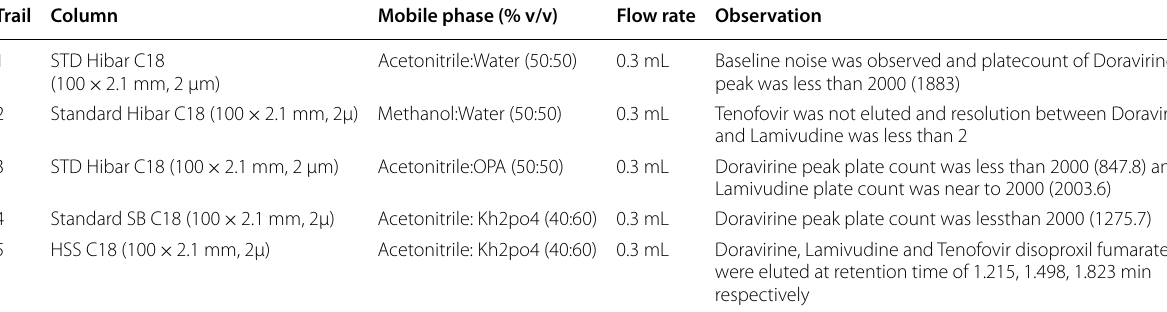
Table 1 Different trails